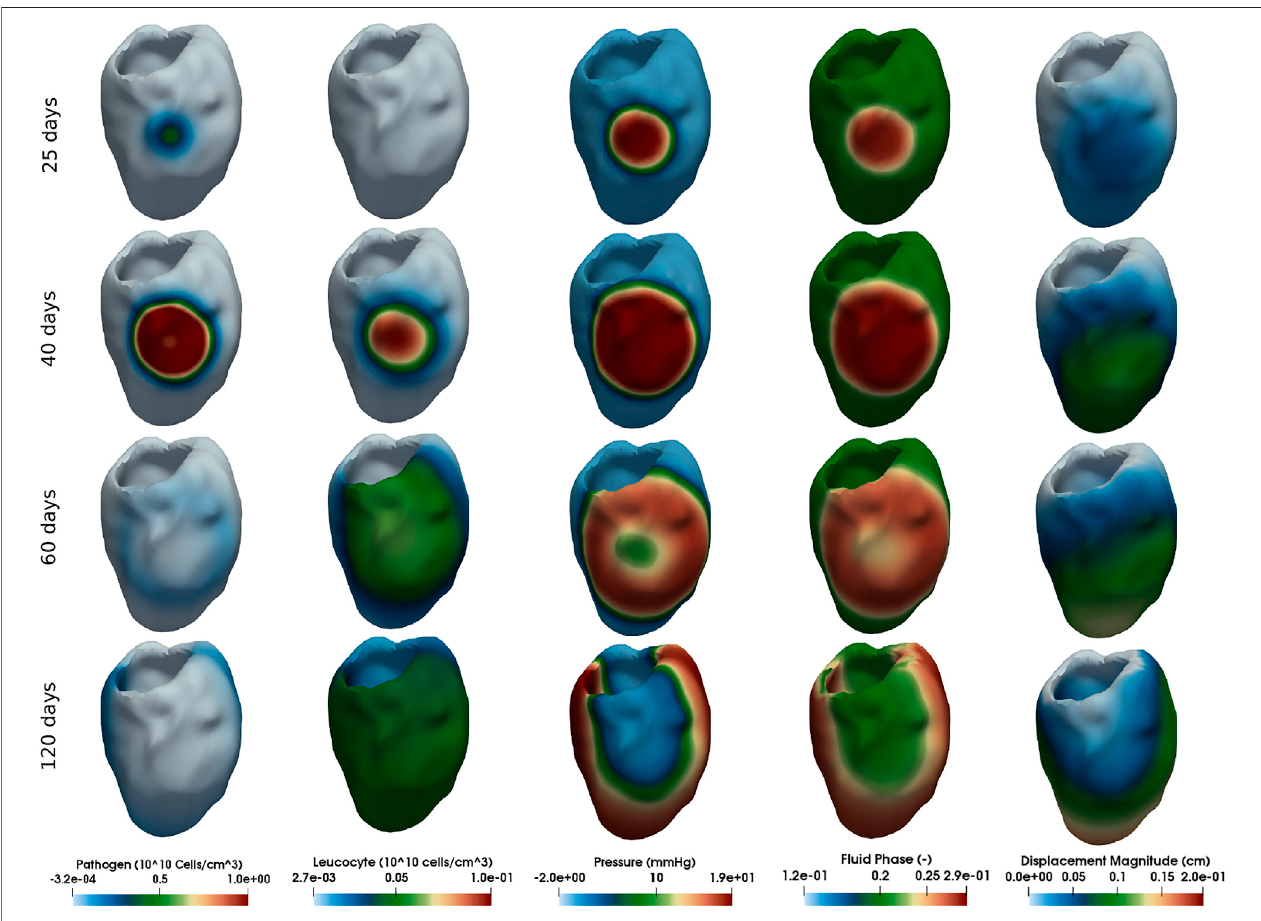
FIGURE 4 | Simulation of diffuse myocarditis in a 3D patient-speci fi c heart geometry using the reference parameter values described in Tables 1 , 2 (those from column Diffuse Myocarditis 3D). The rows present snapshots of the solution at different time instants (25, 40, 60, and 120 days) for each variable (columns).